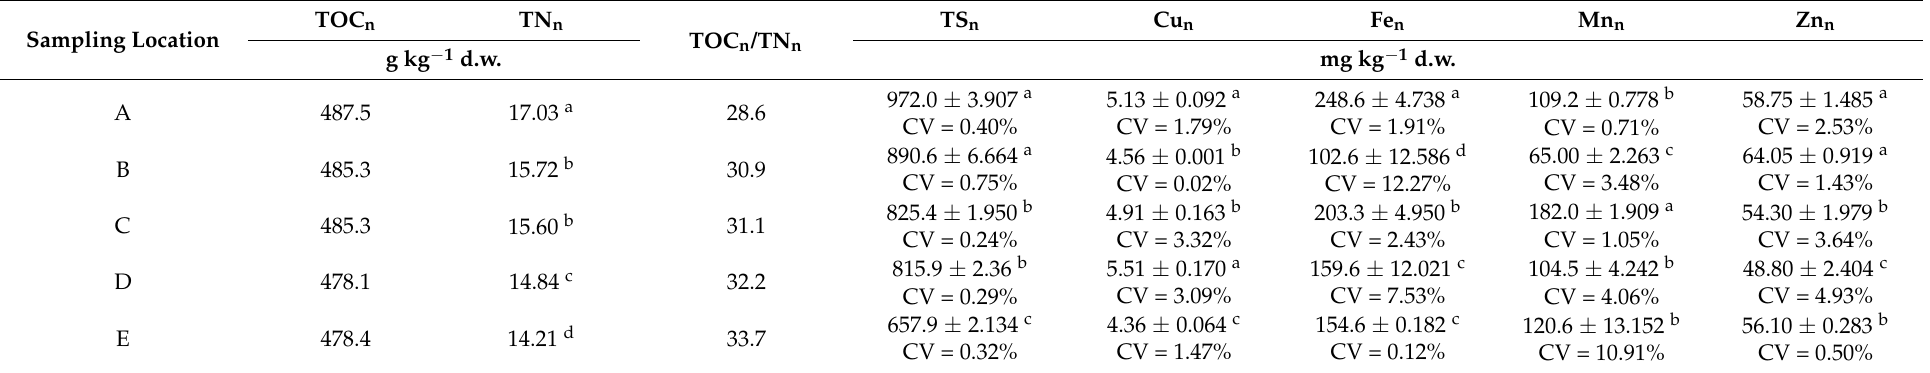
Table 3. Total nitrogen (TN n ), total organic carbon (TOC n ) (g kg − 1 d.w.), total sulphur (TS n ), total metals: Cu n , Fe n , Mn n , Zn n. (mg kg − 1 d.w.) and the ratio of carbon to nitrogen content (TOC n /NT n ) in the dry weight of pine needles.